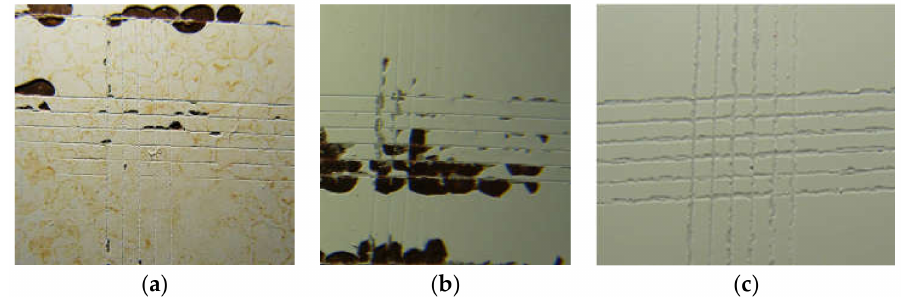
Figure 10. Appearance of the surface affected by the cross-cut area performed after the damp heat test, for ( a ) the sample with sand from Ouarzazate, ( b ) the sample with sand from Dubai, and ( c ) the sample without sand.